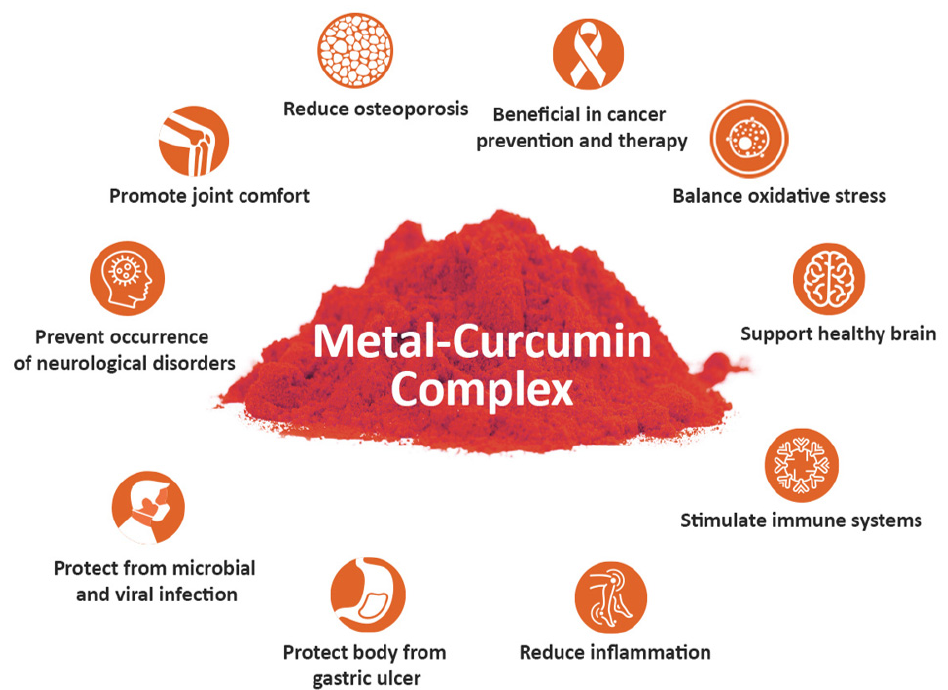
Figure 5. Beneficial health effects and preventive and therapeutic effects of curcumin–metal complexes against various diseases and disorders. Table 2. Prevention and treatment of chronic inflammatory diseases by metal–curcumin complexes.